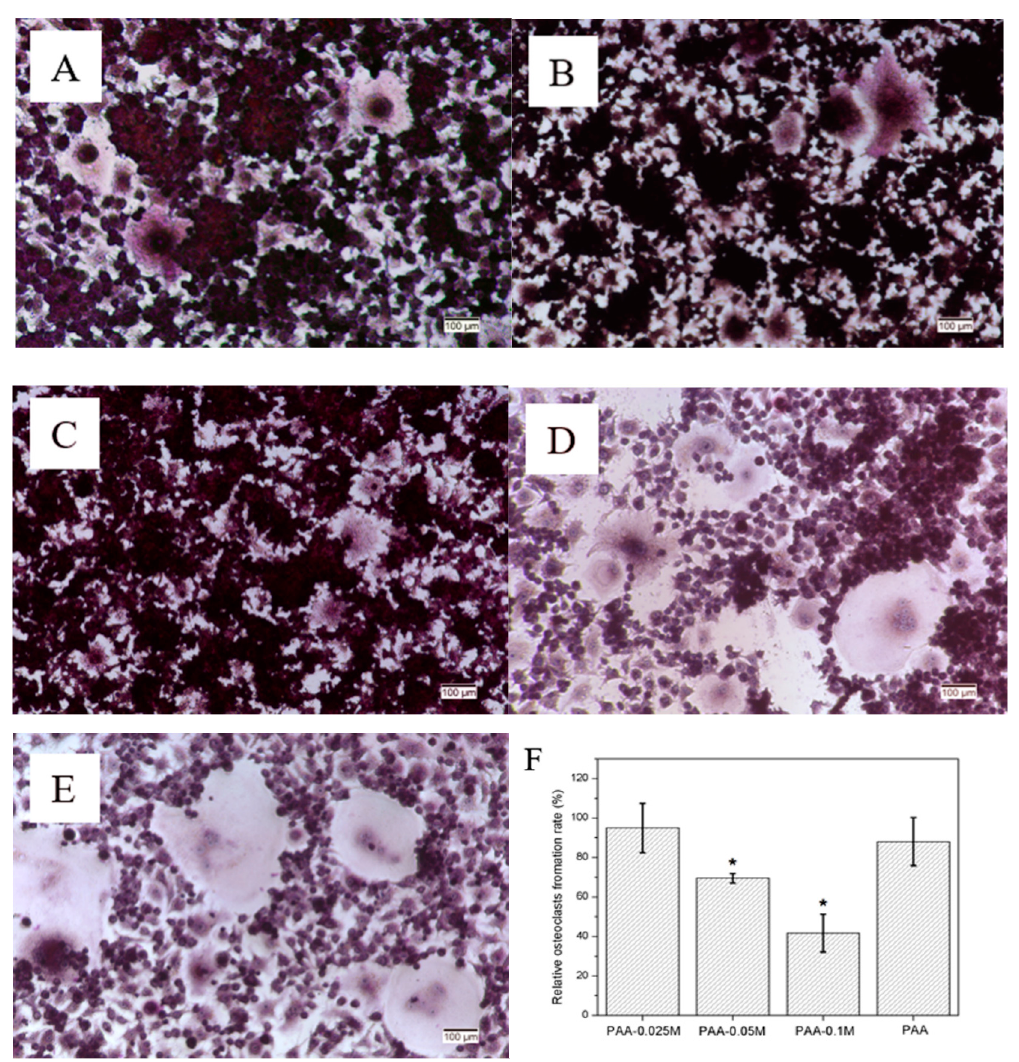
Figure 6. RAW264.7 cultured with ( A ) PAA–0.025M; ( B ) PAA–0.05M; ( C ) PAA–0.1M; ( D ) PAA and ( E ) control in a Transwell plate stimulated by 25 ng/mL RANKL at 5 days under an optical ( E ) control in a Transwell plate stimulated by 25 ng / mL RANKL at 5 days under an optical microscope; microscope; the scale bar: 100 μ m; and ( E ) the relative osteoclasts’ formation rate of the Zn–PAA and the scale bar: 100 µ m; and ( E ) the relative osteoclasts’ formation rate of the Zn–PAA and PAA groups. PAA groups. (* p < 0.05). (* p <